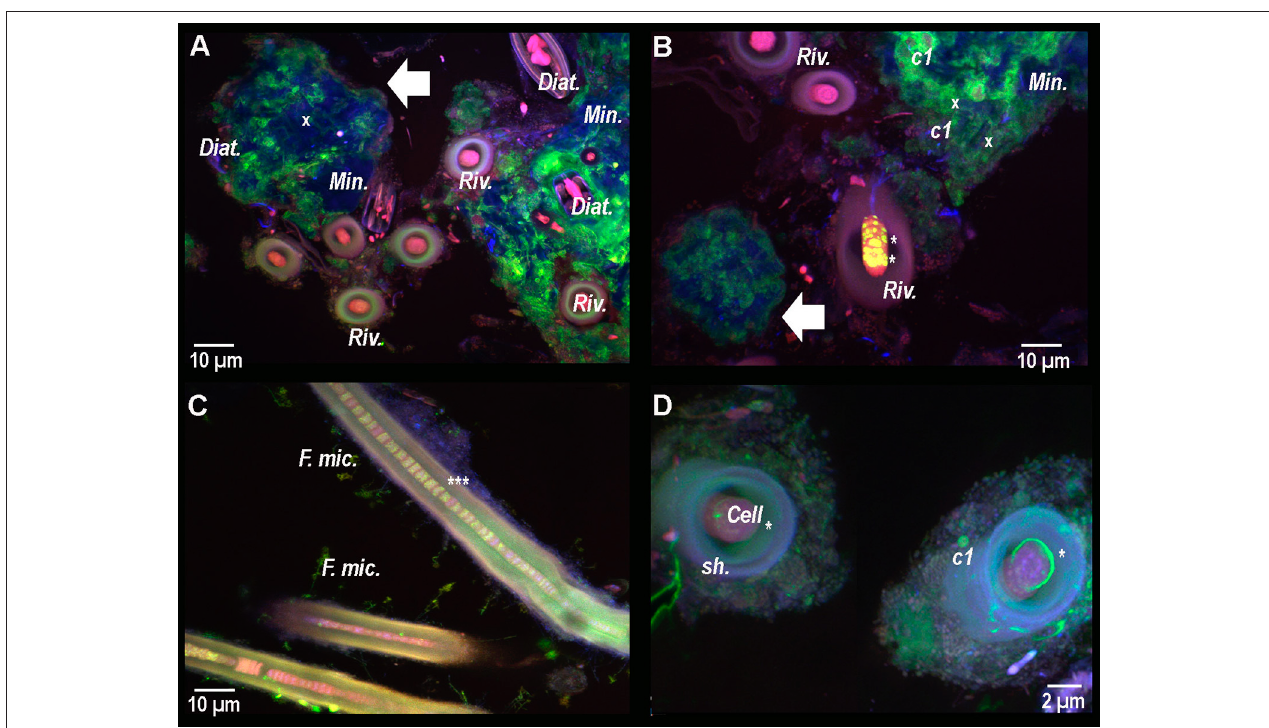
FIGURE 7 | Composite CLSM images of a resin-embedded black pustular microbialite, stained with calcein. Images were obtained with concomitant excitations at 405, 488, and 543nm and collection between 425 and 475nm, 500 and 530nm, and 560 and 660nm, respectively. Fluorescence emission between 500 and 530nm emerges specifically from calcein (in green). (A) Mineral aggregates ( Min. and white arrow) are observed in blue. Their surfaces are partially stained with calcein, hence indicating the presence of free Ca 2 + ion. Inside and surrounding the mineral aggregate, diatom frustules (x) and living diatoms ( Diat. ) are visible thanks to their photosynthetic pigments. Some Rivularia filaments ( Riv. ) seem to be separated from the mineralized aggregates, while other filaments are close but not entombed in the aggregate and occur with diatoms. Calcein stained the space inside the filaments, i.e., between the sheath and the cells. In (B) yellow/light green dots are observed in one of the Rivularia filament (*). Calcein also strongly stained the contours of the pigmented c1 cocci-shaped cell colonies that were found closely associated with the mineral aggregates (white arrow). (C) Close up view of calcein-stained Rivularia filaments. The dye also stained some other filamentous microorganisms associated with the Rivularia sheath ( F. mic. ). Inside the Rivularia filament, some green dots are distinguishable (***). (D) Image of two transversally-cut Rivularia filaments, where calcein fluorescence (*) was also found between the cells and the sheath ( sh. ); as in (C) , calcein also stained the c1